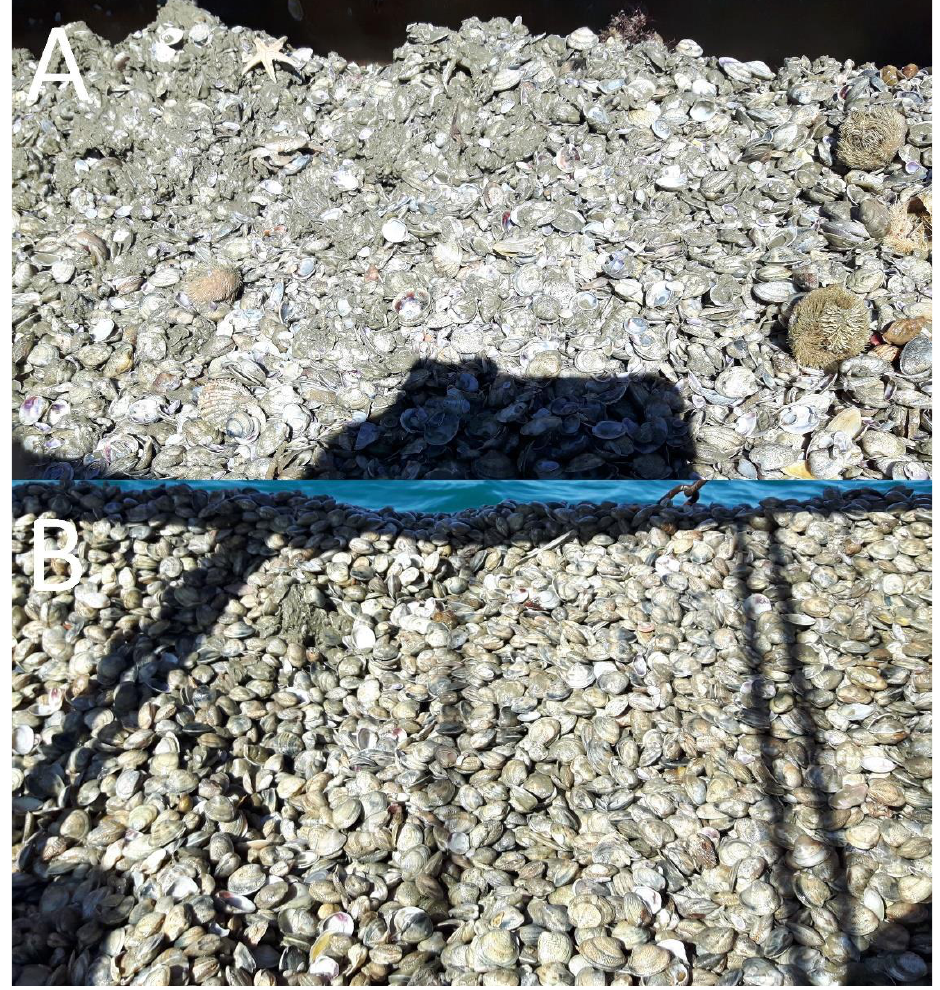
Figure 4. Comparison of the unsorted catch between traditional ( A ) and innovative ( B )